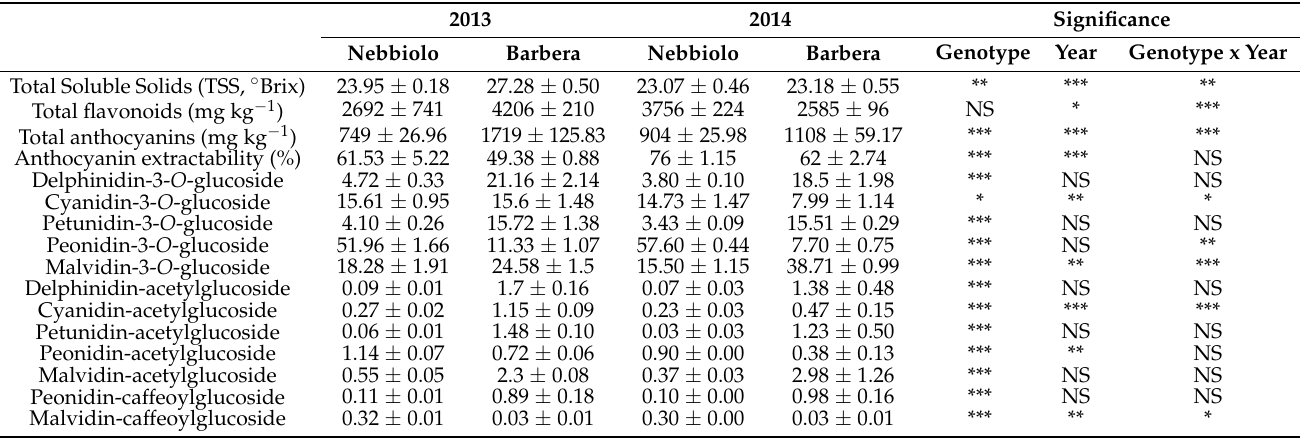
Table 1. Total Soluble Solids (TSS, ◦ Brix) determined at commercial harvest, total anthocyanins and flavonoids (mg kg − 1 ), anthocyanin extractability, and anthocyanin profiles (percent) in the skin of grapes collected at 24 ◦ BRIX from ‘Nebbiolo’ CVT71 and ‘Barbera’ CVT115 in 2013 and 2014. Data are means ± standard error ( n = 21). Significance of genotype, year, and effects of the genotype × year interaction were tested for p ≤ 0.05 (*), p ≤ 0.01 (**), and p ≤ 0.001 (***); NS, not significant.